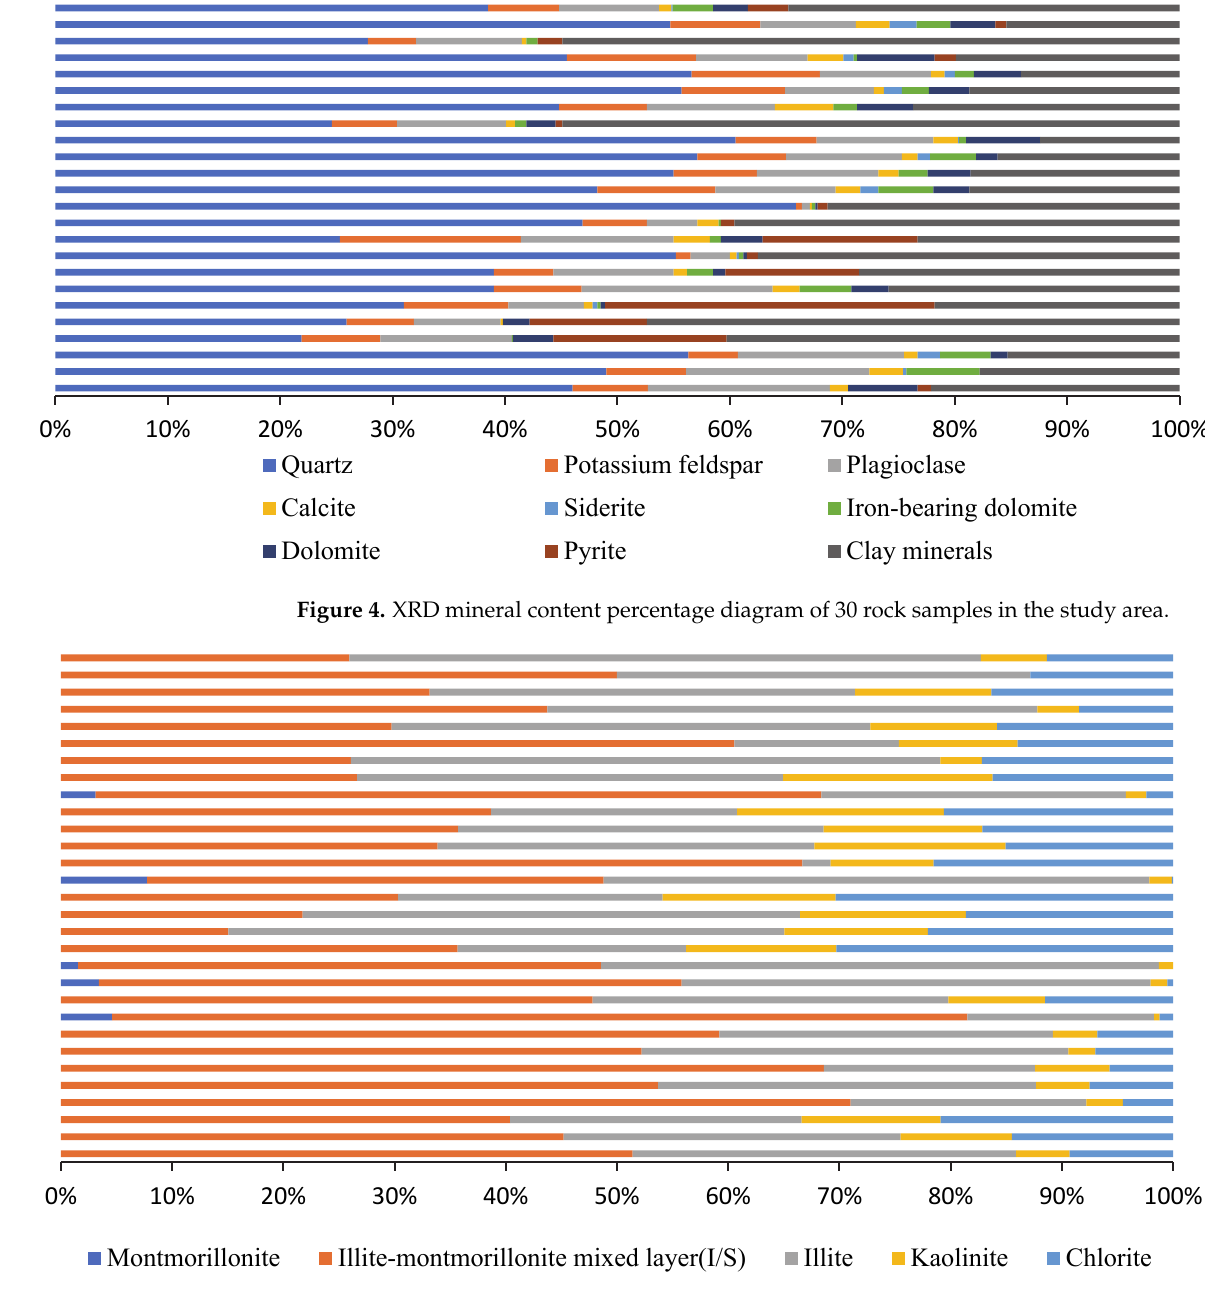
Figure 5. XRD chart of clay mineral content percentage of 30 rock samples in the study area.